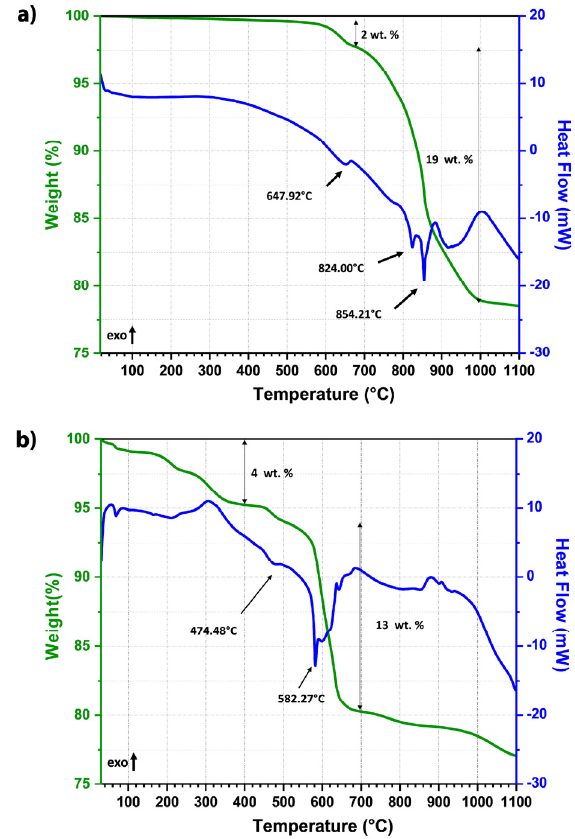
Figure 1. Thermal analysis (green solid line is weight of powder and blue solid line is heat flow) of mixed raw materials before ( a ) and after ( b ) attrition milling treatment for 6 h.